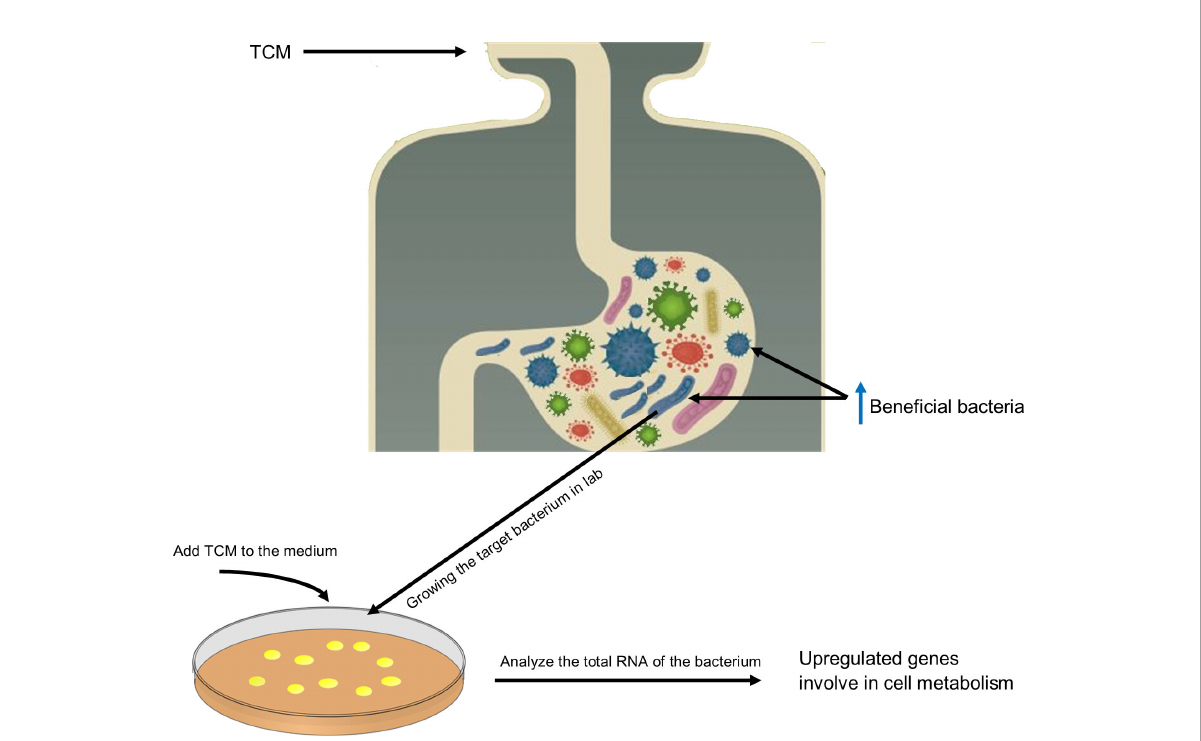
FIGURE 2 Graphic illustration of the TCM effect on GM composition and gene expression and a guide to investigate the TCM – GM interaction. This illustration shows the direct effect of TCM on GM composition. TCM intake promotes growth of certain bacteria; for instance, in the case of saponins, B animalis and L. reuteri become abundant. To check how TCM modulates the genome expression of microbes, target bacteria should be culture in vitro in the presence of TCM, and their growth kinetics and gene expression should be monitored. In the case of saponins, it is observed that saponins promote the expression of genes involved in metabolism and biogenesis that contribute to promoting growth of these bacteria in a